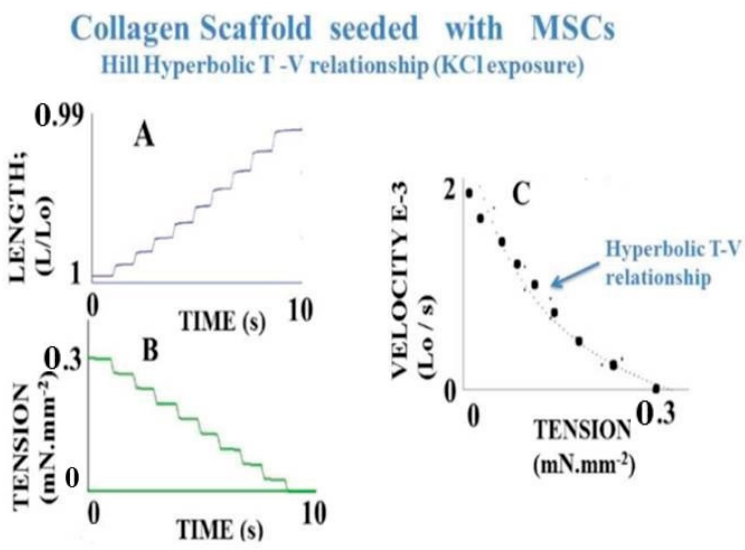
Figure 2. Hill hyperbolic tension (T)-velocity (V) relationship: The T-V hyperbolic relationship is established from a KCl-activated scaffold seeded with MSCs. Length (panel A ) is progressively increased and tension (panel B ) is progressively decreased by imposing several successive load clamps (LC). LC induces a brief transient overshoot. Maximum shortening velocity corresponding to a new isotonic load level is measured. (Panel C ) represents the Hill hyperbolic T-V relationship. The curvature of the hyperbolic T-V relationship is introduced into Huxley’s equations to determine the molecular myosin properties (Table 1). This cardinal mechanical property is shared by both contractile muscles and non-muscle